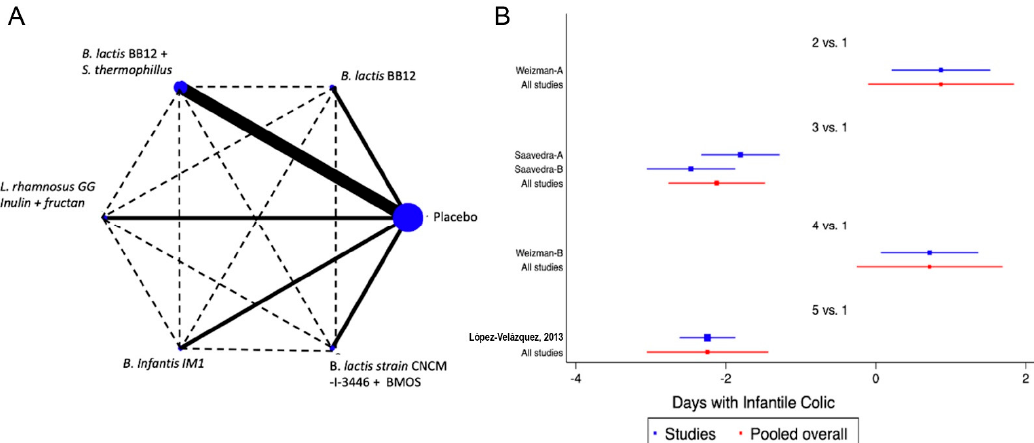
Figure 5. Network Meta-Analysis for probiotics in infant formula and change on weight/height Z